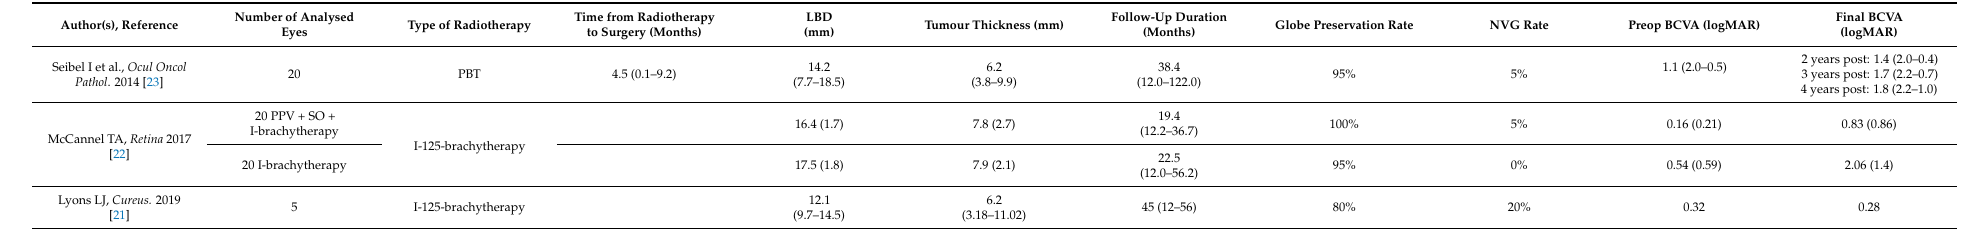
Table 2. Summary of case series on non-resective vitreoretinal surgery techniques in the prevention of toxic tumour syndrome following different types of radiotherapy. LBD = largest basal diameter; NVG = neovascular glaucoma; PBT = proton beam therapy; PPV = pars plana vitrectomy; SO = silicon oil; BCVA = best corrected visual